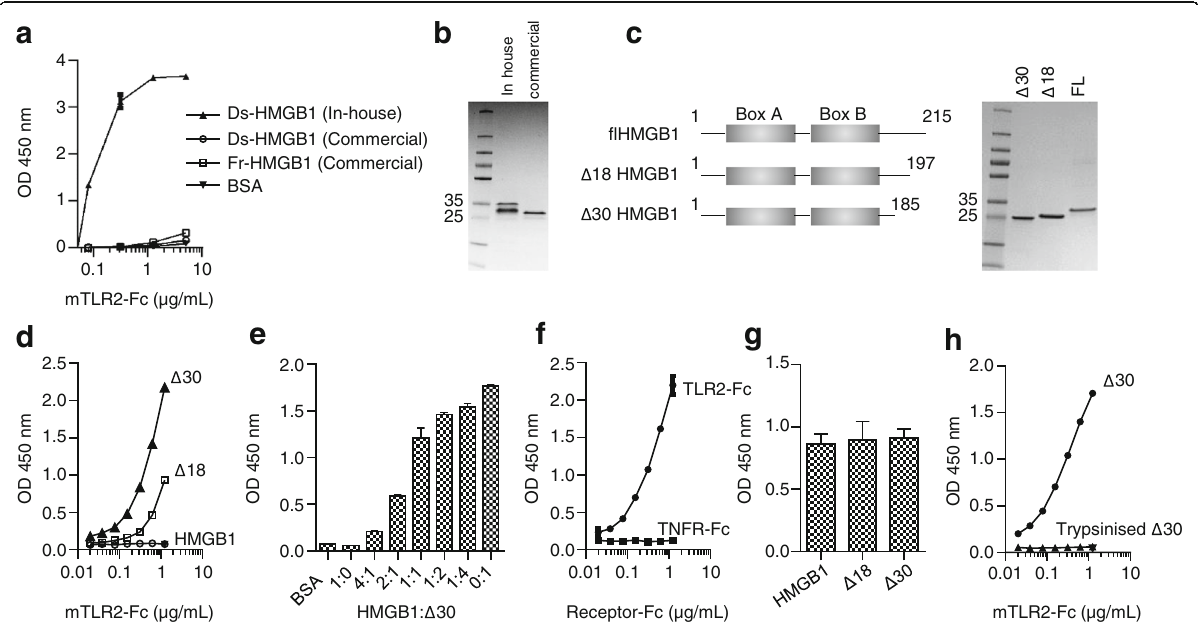
Fig. 1 The C-terminal acidic tail domain inhibits binding of HMGB1 to TLR2. a ) Binding of HMGB1 to TLR2 was investigated by ELISA. Plates were coated with different batches of HMGB1 and incubated with increasing concentrations of TLR2-Fc. No interaction between commercial HMGB1 and TLR2-Fc was detected. In contrast, in-house produced HMGB1 bound to TLR2-Fc in a dose-dependent manner. Ds-HMGB1 = disulfide HMGB1, Fr-HMGB1=fully reduced HMGB1. b ) SDS-page gel electrophoresis analysis of the in-house and commercial proteins confirmed that the commercial preparation only contained full length HMGB1 whilst the in-house preparation was a mixture of full length and C-terminus truncated protein. c ) Schematic structure and SDS-page gel analysis of full length and C-terminal truncated HMGB1 proteins ( Δ 18 and Δ 30) d ) Δ 30 and Δ 18 with a full or partially truncated C-terminus bind to TLR2-Fc as detected by ELISA e ) Increasing concentrations of Δ 30 results in increasing binding to TLR2-Fc. f - h